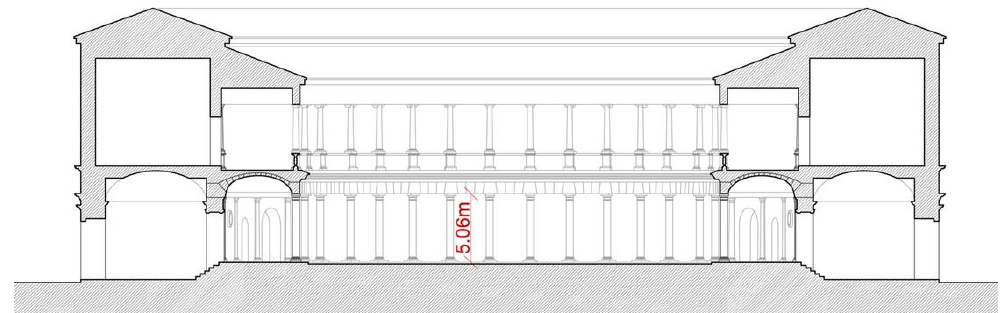
Figure 2. Elevation section of the Palace. Reproduced with permission from the authors.